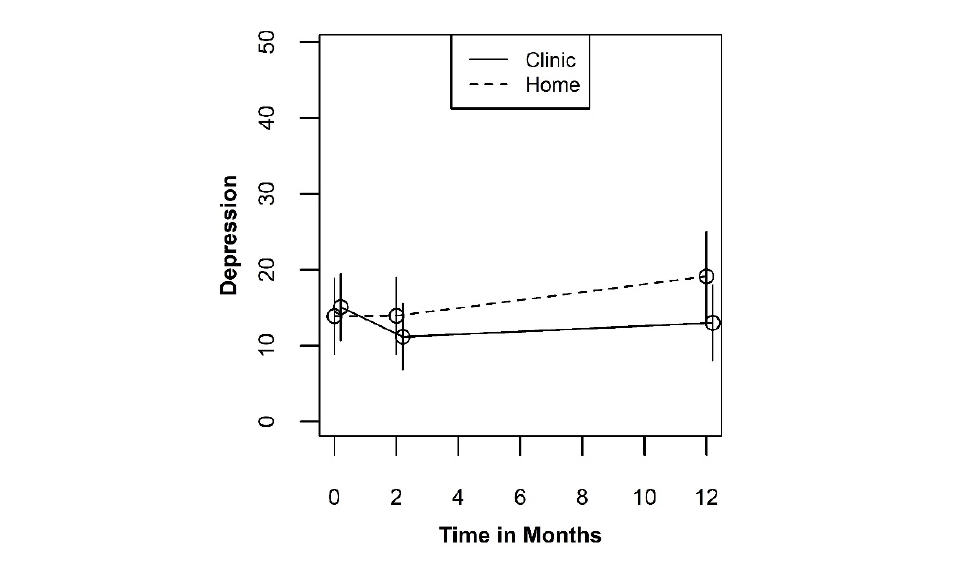
Figure 5. Plots of depression by HIV test result .